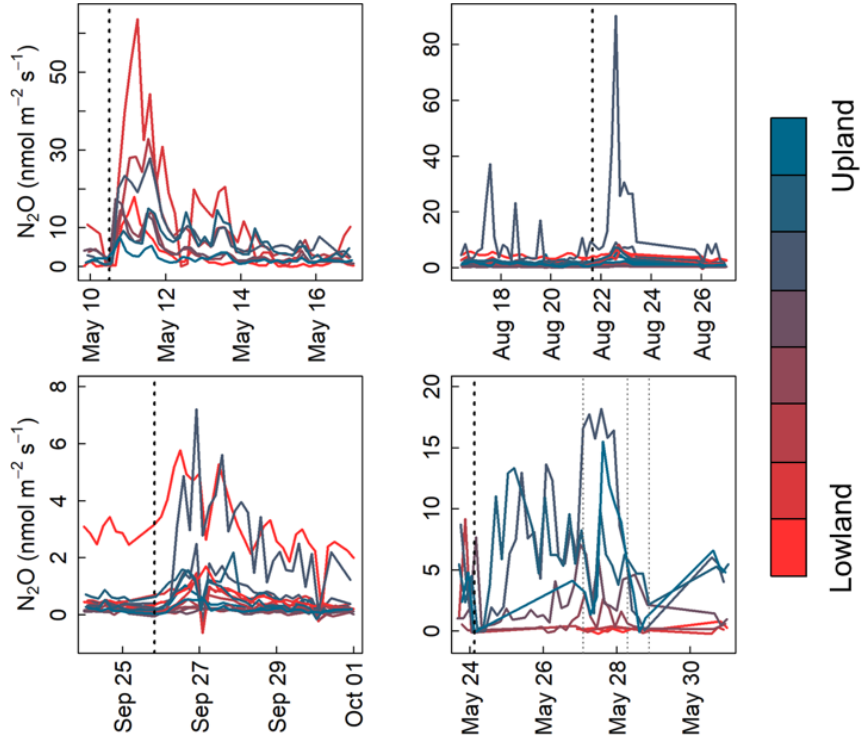
Figure 10. N 2 O flux time series shaded by plot topographic location over four 1-week periods in May 2017, August 2017, September 2017, and May 2019. The dashed black lines denote rain events analyzed for peak delay, and gray lines indicate rain events that did not fit our selection criteria and were > 2mmd − 1